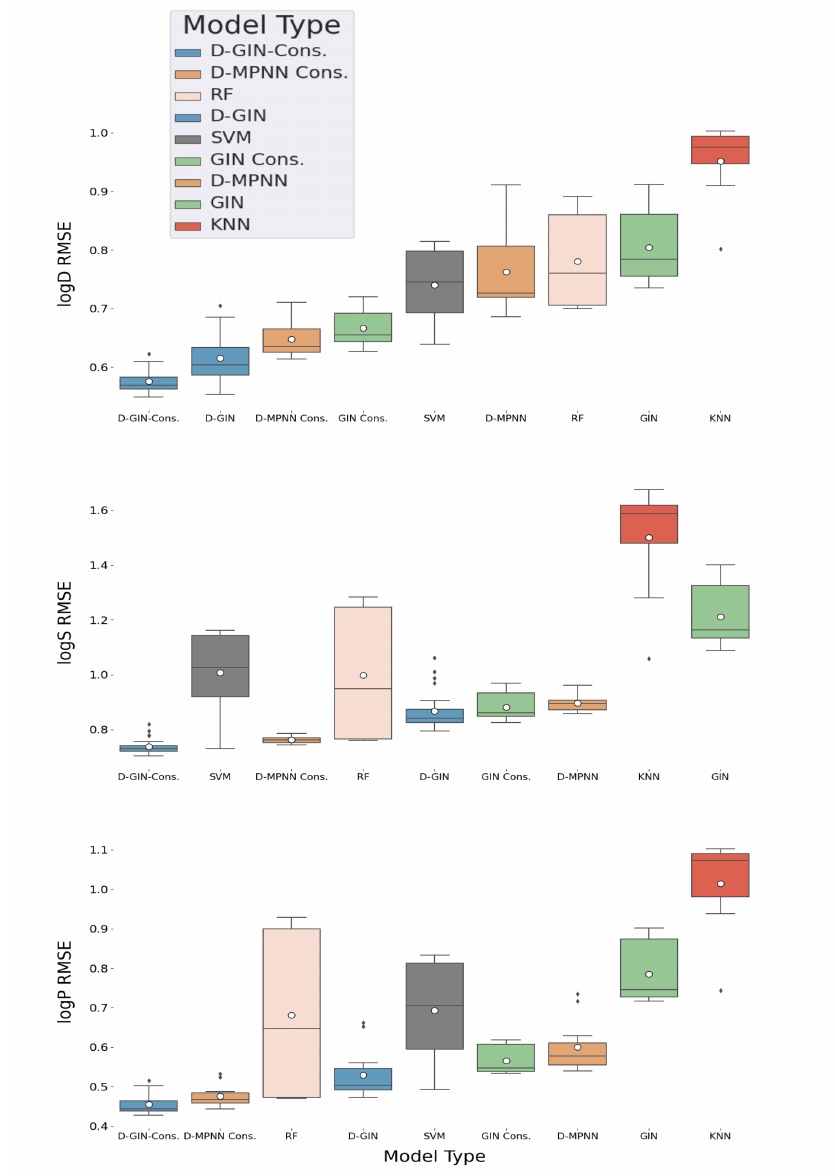
Figure 2. LogD, logS, and logP property prediction results for GNN and non-GNN model types with different featurization and training strategies. The different GNN architectures are colored in blue (D-GIN), orange (D MPNN), and green (GIN), the non-GNN architectures in gray (SVM), salmon pink (RF), and red (KNN) For logD and logS, 24 individual RMSE values were calculated for each model type. For logP 12 individual RMSE values were calculated. The individual boxplots show the average value of each model type as white dot and the median as a dark gray line. The values are listed in Tables A8–A19 in the Appendix